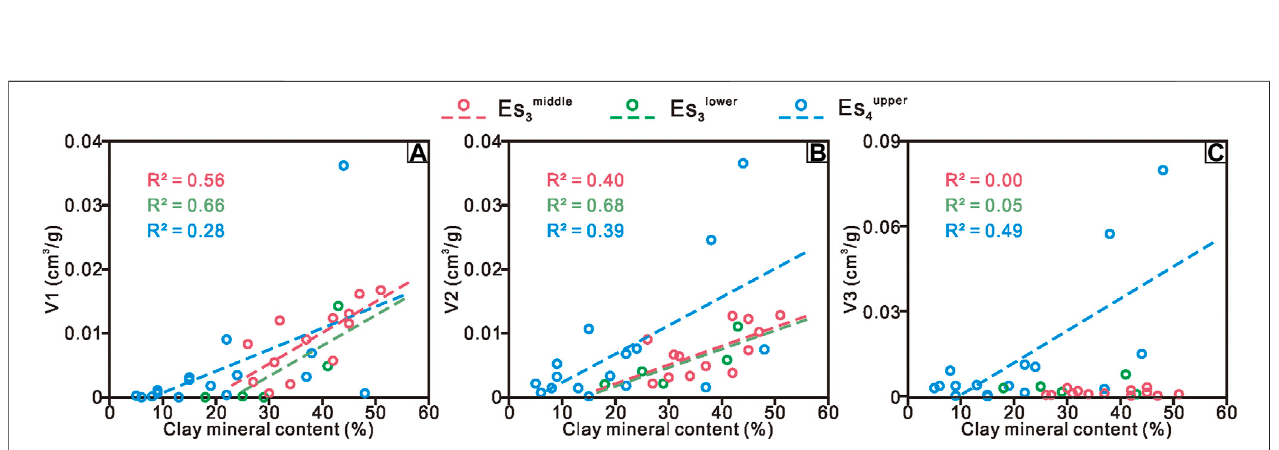
FIGURE 8 | (A) relationships between V1 and clay mineral content; (B) relationships between V2 and detrital mineral content; (C) relationships between V3 and carbonate mineral content.